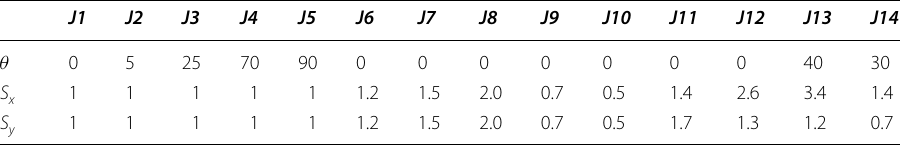
Table 3 Type of geometric attack in MICC‑F2000 dataset